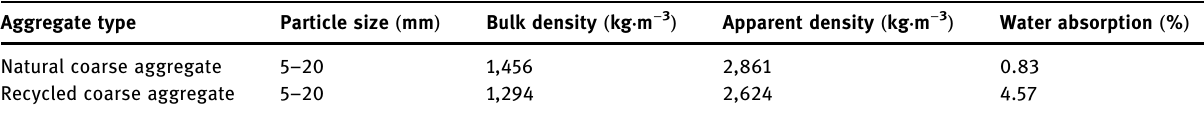
Table 4: The basic performance of coarse aggregate Aggregate type